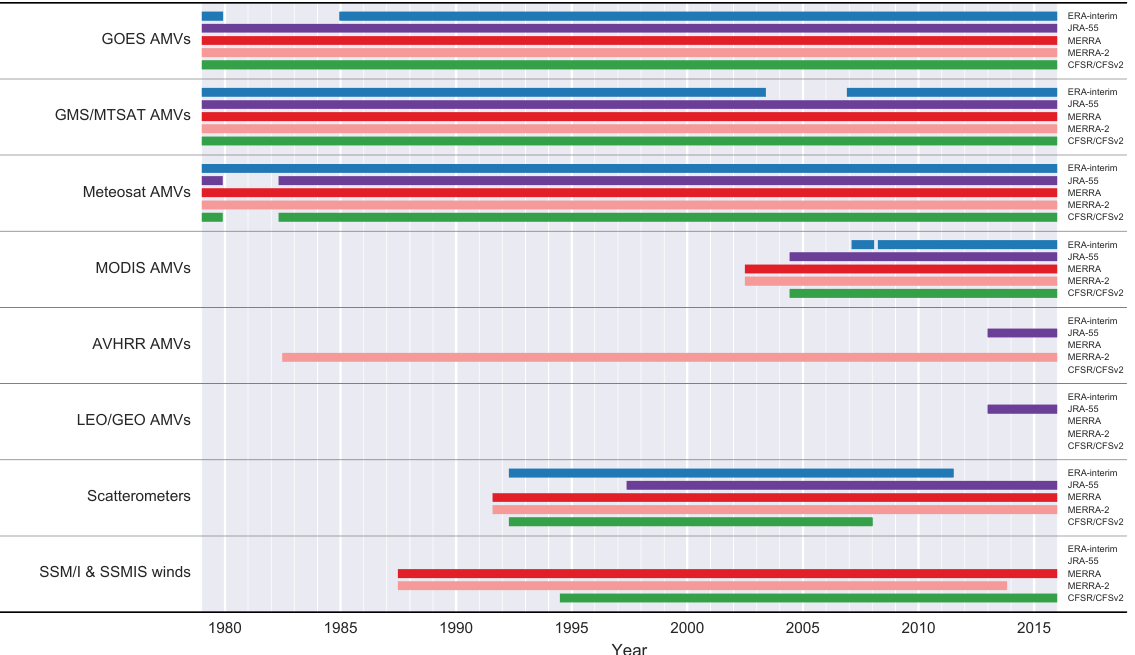
Figure 9. As in Fig. 6, but for AMVs and ocean surface wind products derived from satellites and assimilated by the reanalysis systems.